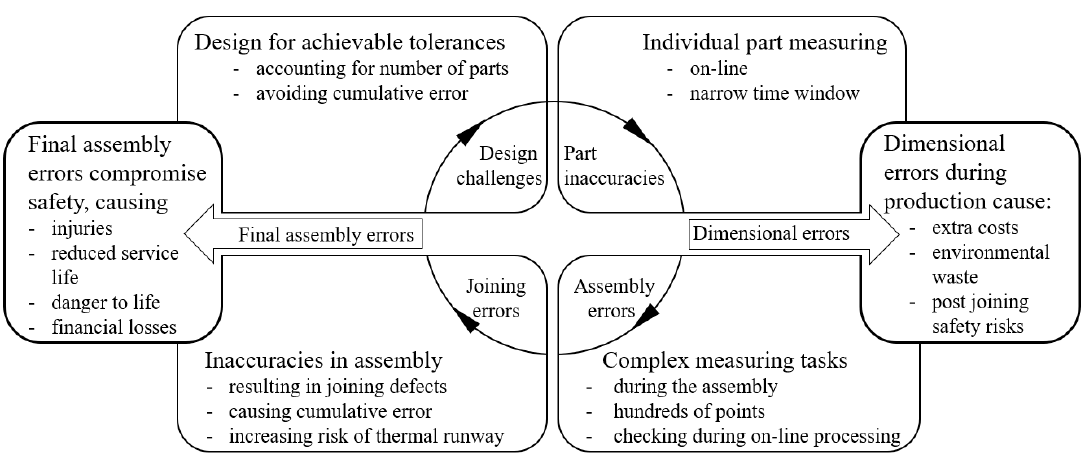
ff in battery cell